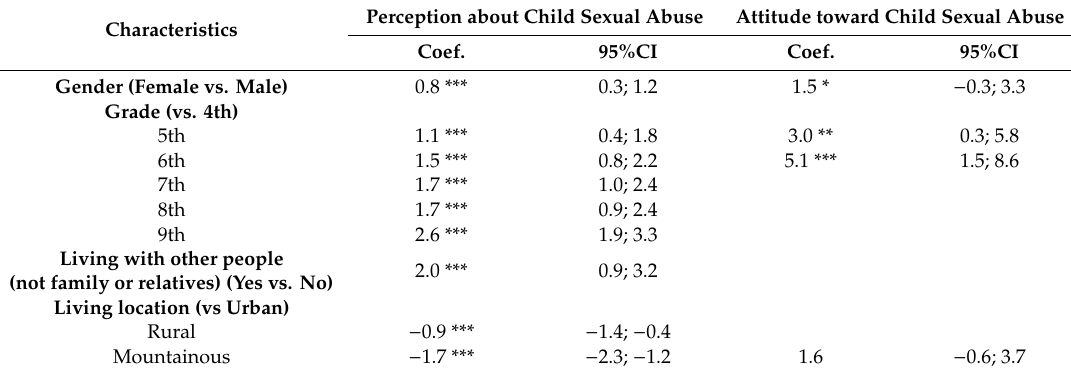
Table 4. Factors associated with perception and attitude toward child sexual